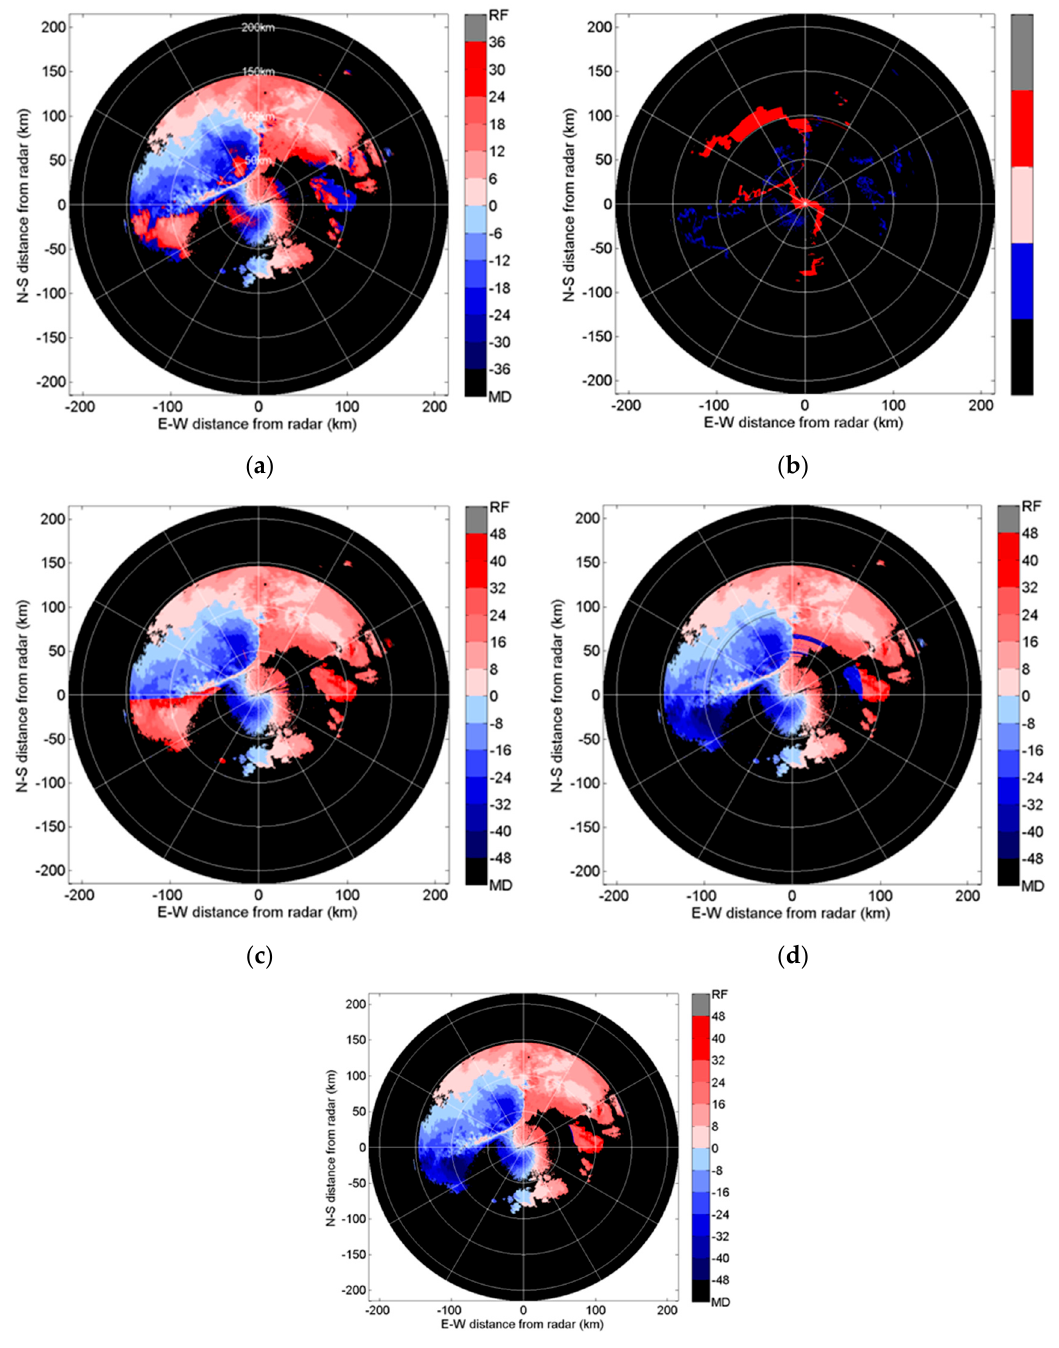
Figure 4. Radar radial velocity at elevation angle of 4.3 ◦ from the CINRAD S-band radar system in Guangxi province of China at 20:28 (UTC), 30 Mar 2014. ( a ) Raw radial velocity, ( b ) flag 3 showing the real shear regions and the first reference radial shown by the yellow line, ( c ) dealiased result after the first two steps in module 4, ( d ) dealiased result after the last two steps in module 4, and ( e ) dealiased result after module 5. The Nyquist velocity for the Guangxi radar is 27.12 m s − 1 . The spatial scales of the pairs of images are di ff